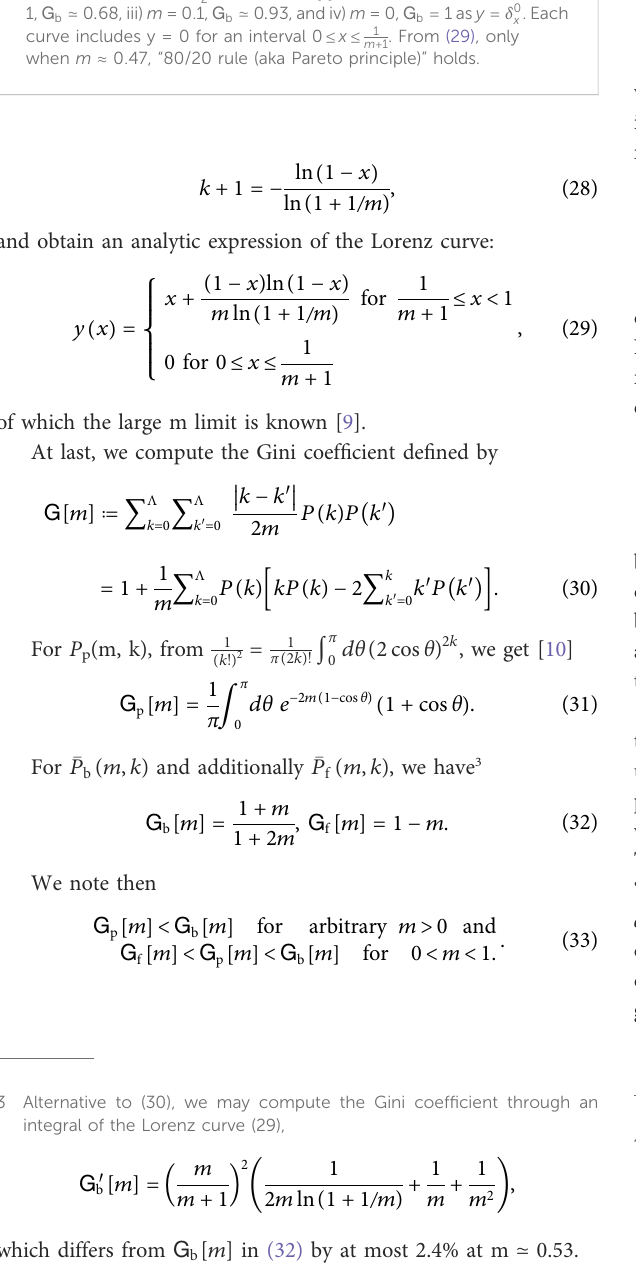
FIGURE 3 Lorenz curves of the geometric distribution (cid:2) P b ( m , k ) for identical assaturatedby y = x +(1 − x )ln(1 − x )[9],ii) m = wealth.i) m = ∞ , G b (cid:2) 1 2 1, G b ≃ 0 . 68,iii) m =0.1, G b ≃ 0 . 93,andiv) m =0, G b (cid:2) 1as y (cid:2) δ 0 x .Each curve includes y = 0 for an interval 0 ≤ x ≤ 1 m + . From (29), only 1 when m ≈ 0.47, “ 80/20 rule (aka Pareto principle) ”